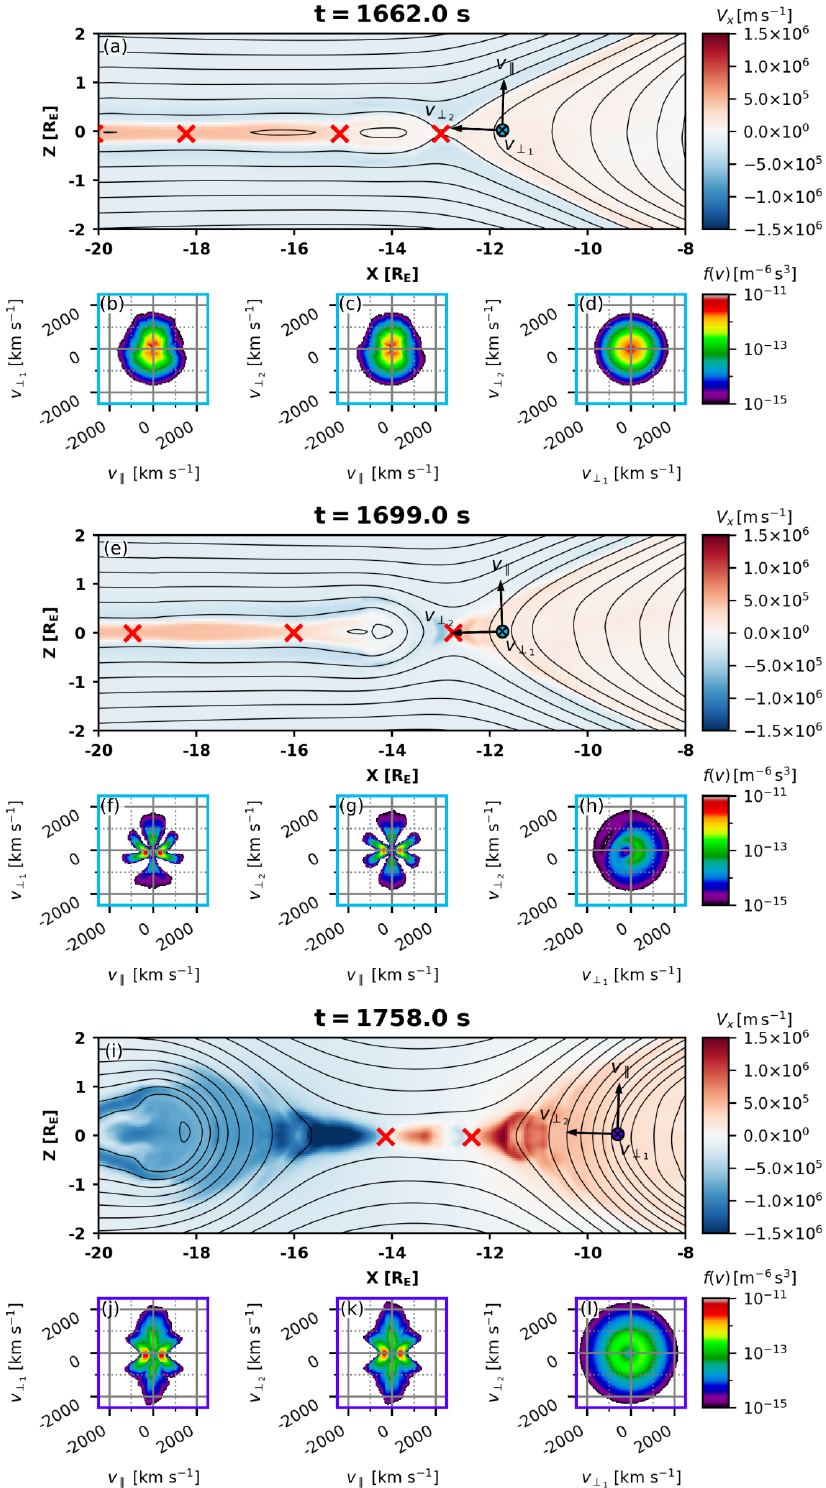
Figure 3. (a) X component of the plasma bulk velocity in the magnetotail at t = 1662 . 0s with magnetic field lines and X points indicated as in Fig. 2. A virtual spacecraft is placed near ( X = − 12 R E , Z = 0) to monitor the plasma earthward from the major X line; arrows and labels indicate the local plasma frame (see text for details). (b–d) Slices of the 3D VDFs (velocity distribution functions) at the virtual spacecraft in the { v (cid:107) , v ⊥ }, { v (cid:107) , v ⊥ }, and { v ⊥ , v ⊥ } planes. (e–h) The same, but at t = 1699 . 0s. (i–l) The same, but at t = 1758 . 0s and using a different 1 2 1 2 virtual spacecraft observing plasma on the same magnetic field line as in (e) – (h) after it has convected